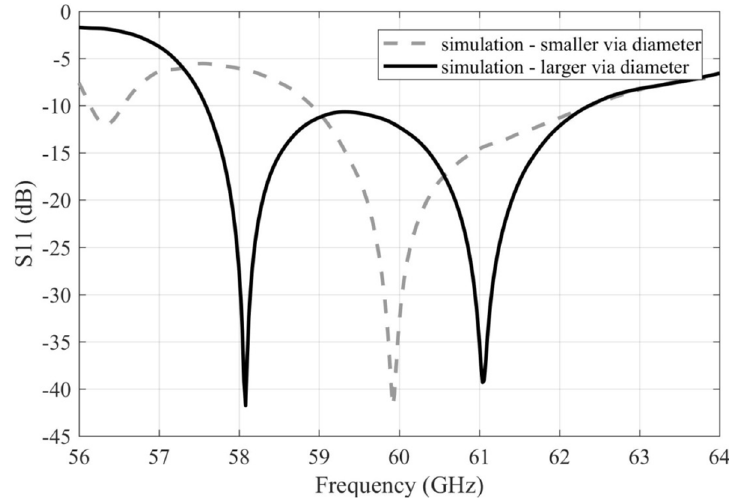
Figure 6. Frequency responses of the magnitude of the reflection coefficient for the simulated arrays with smaller and larger vias.